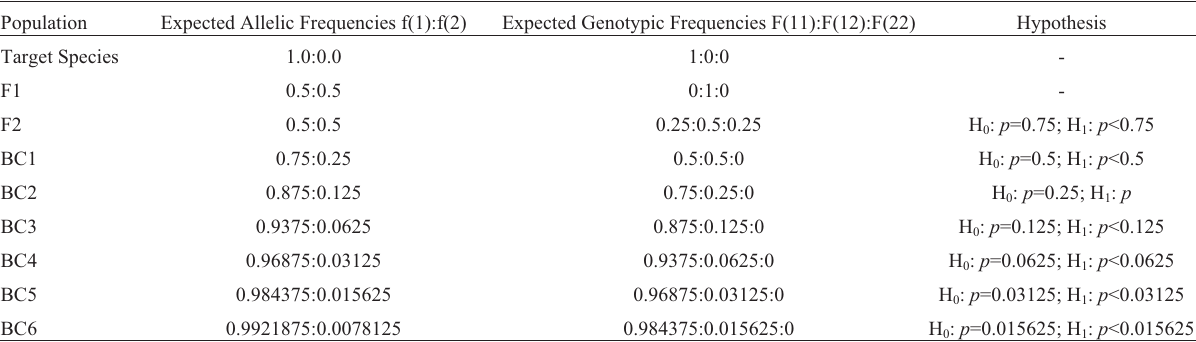
Table 1 - Expected allelic and genotypic frequencies in different intercross and backcross populations between a target and a non-target species and re- spective hypothesis for statistical tests for hybrid identification. Population Expected Allelic Frequencies f(1):f(2) Target